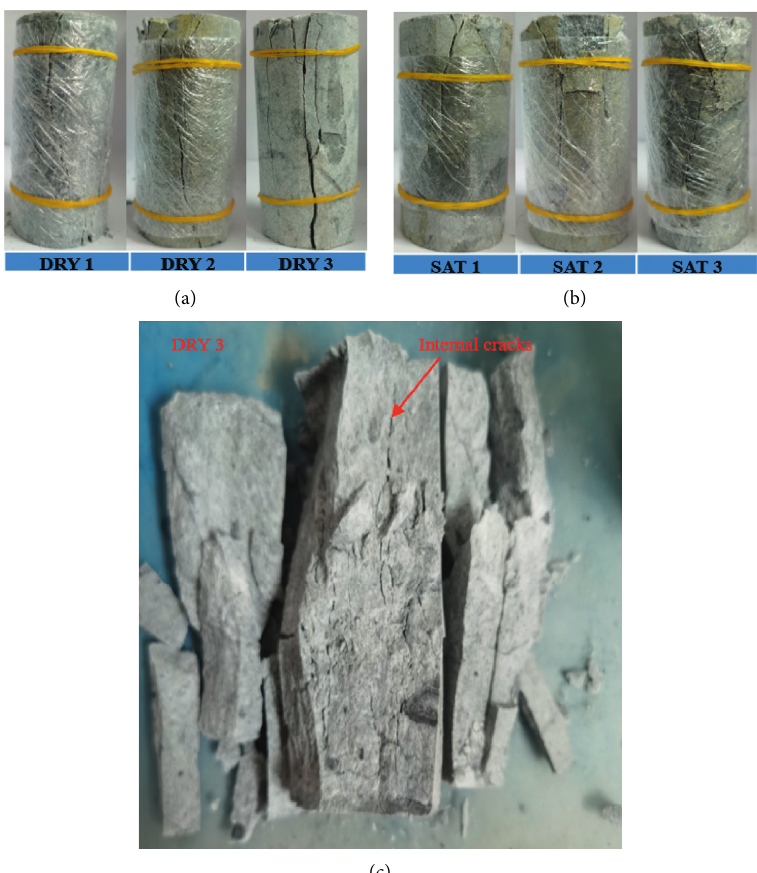
Figure 9: Macrofracture characteristic pattern of the tuffs in the tunnel of Mila Mountain after uniaxial